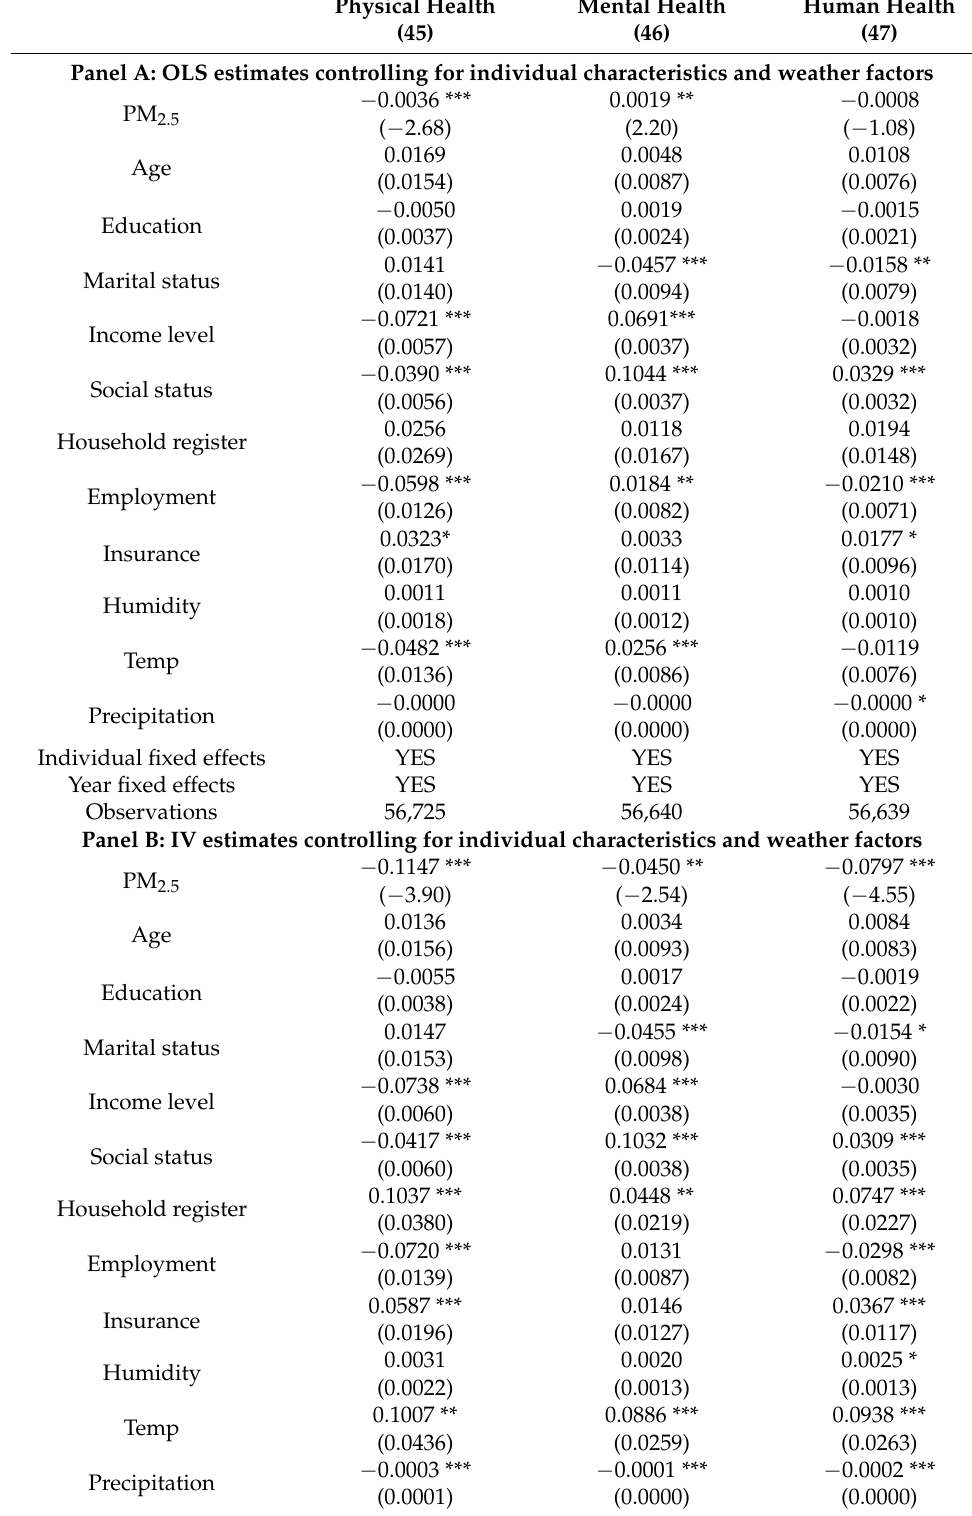
Table A1. OLS and IV estimates of the influence of air pollution on physical, mental, and human health.